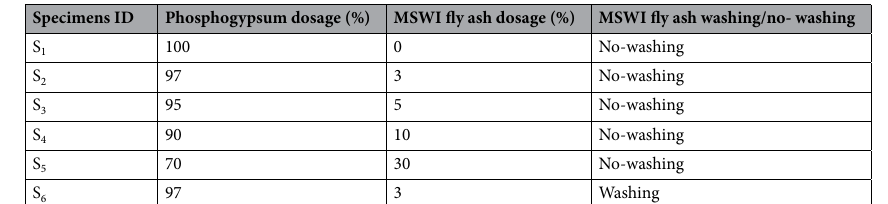
Table 5. Mixing design of binder material.